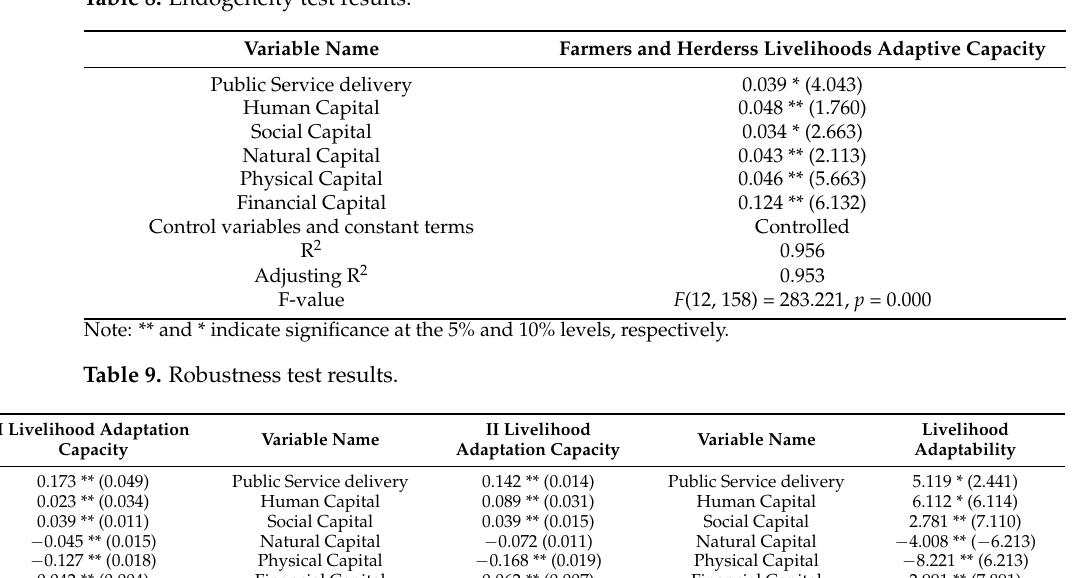
Table 8. Endogeneity test results.